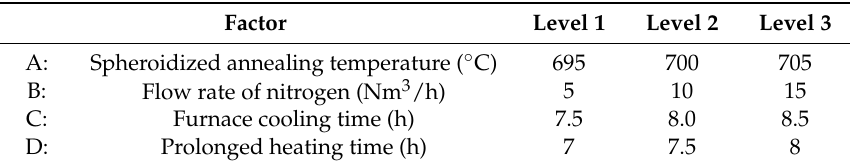
Table 2. Experimental factors and their levels for L 9 orthogonal